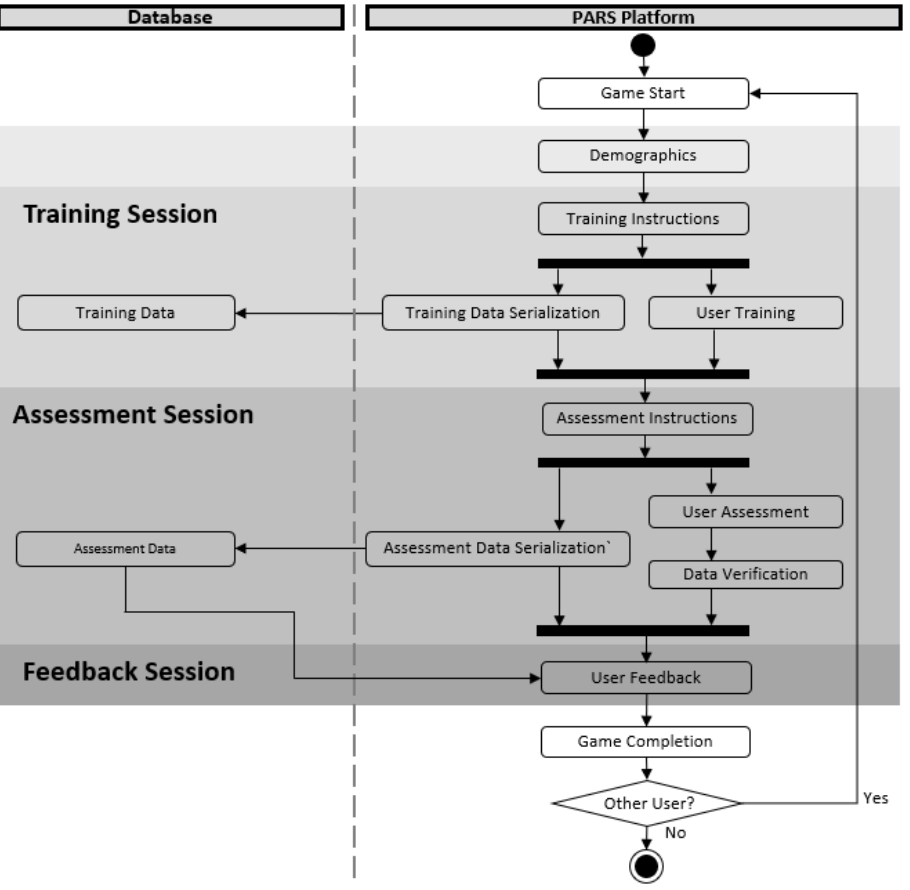
Figure 2. Platform Data Management using an UML diagram.